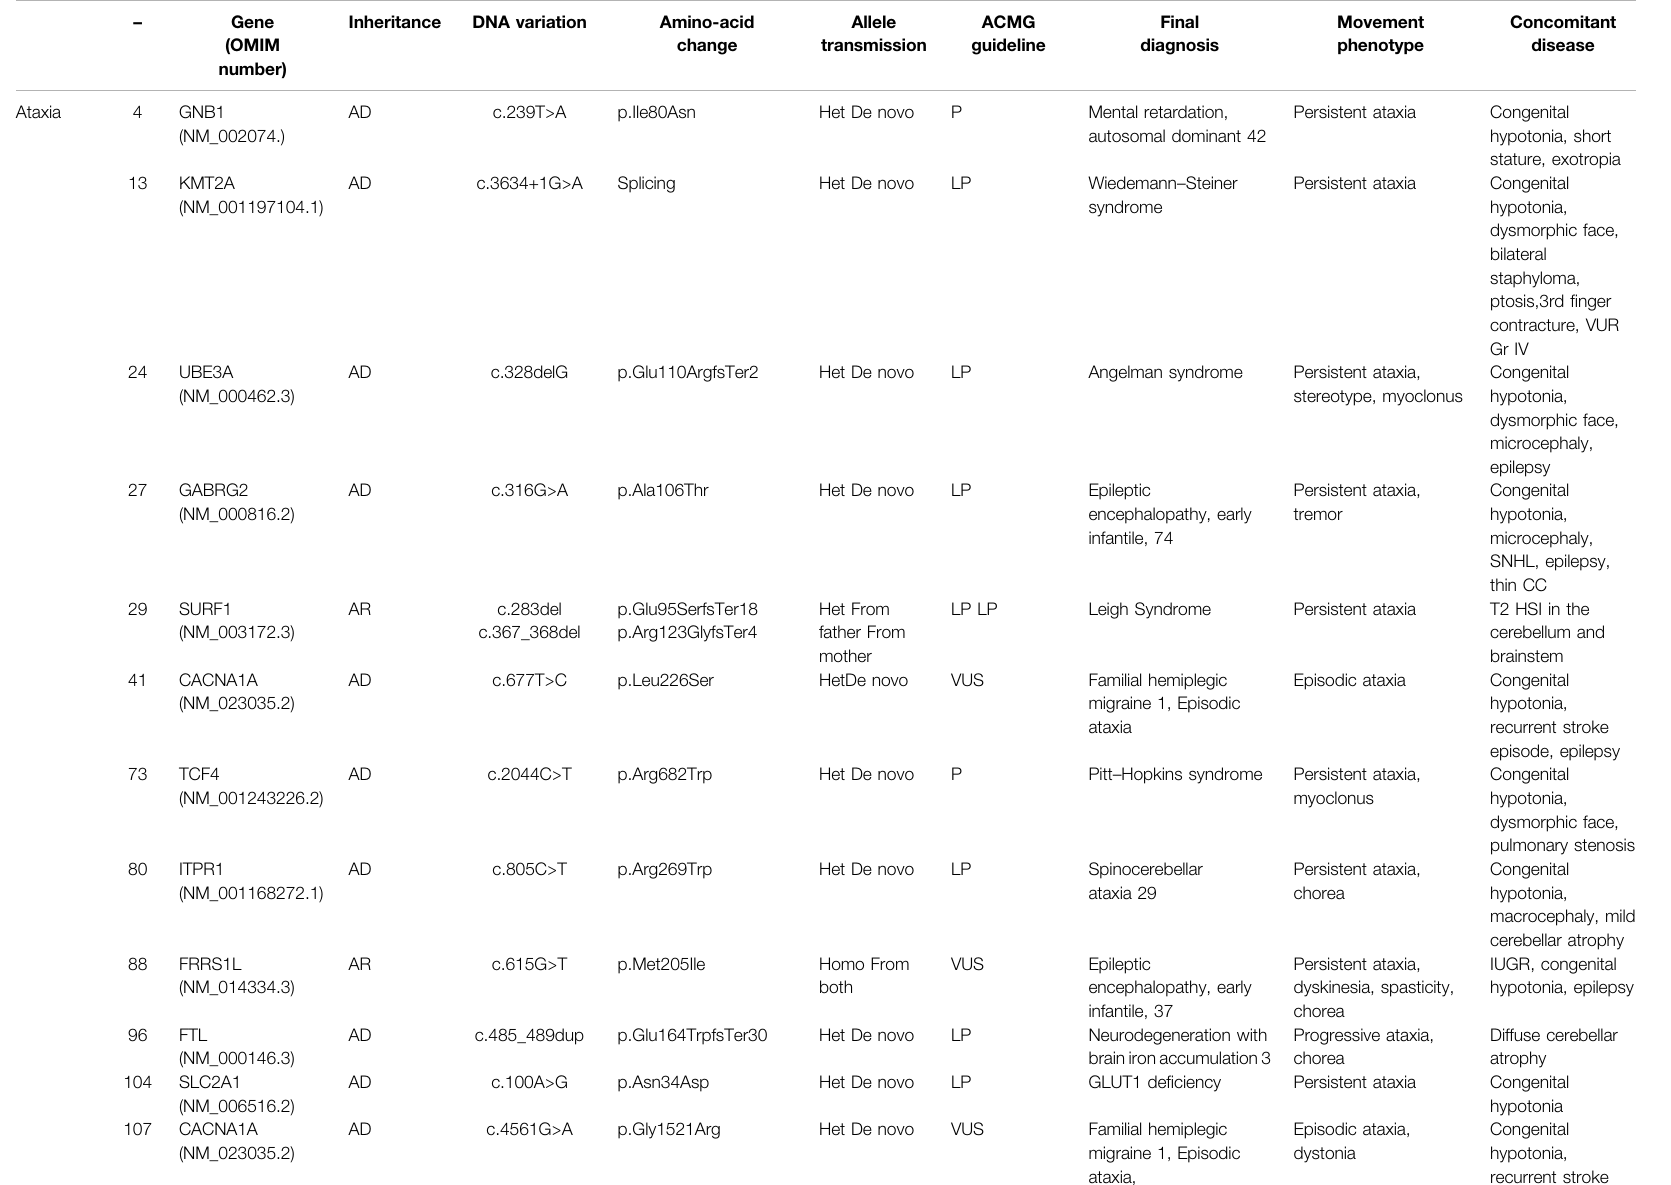
TABLE 2 | Identi fi ed variants in our cohort classi fi ed on the basis of prominent movement